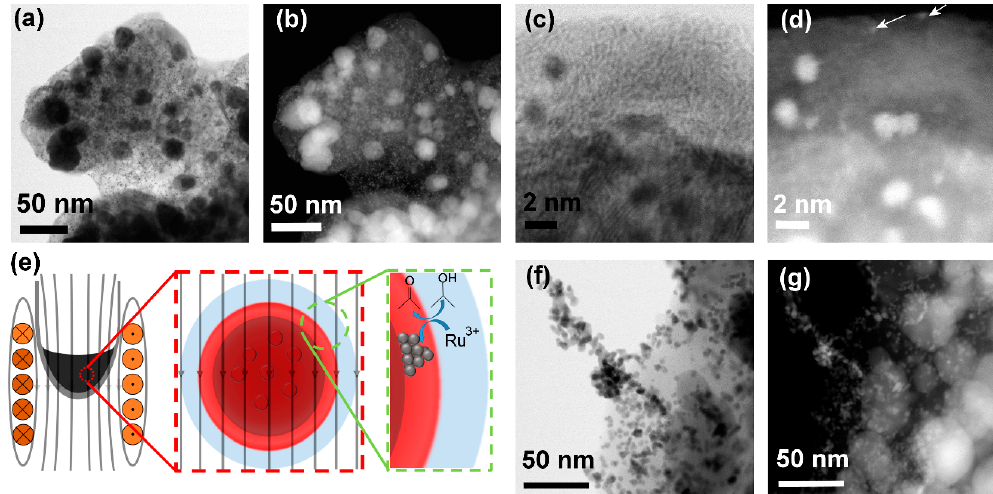
Figure 2. ( a , c ) Bright Field (BF) and ( b , d ) High Angle Annular Dark Field (HAADF) scanning transmission electron microscope (STEM) images of the nanocatalyst AC ‐ Ru. ( e ) Schematic illustration of the magnetically mediated synthesis of the nanocatalyst AC ‐ Ru. (f) BF and ( g ) HAADF STEM images of the nanocatalyst CH ‐ Ru. Arrows in ( d ) show Ru